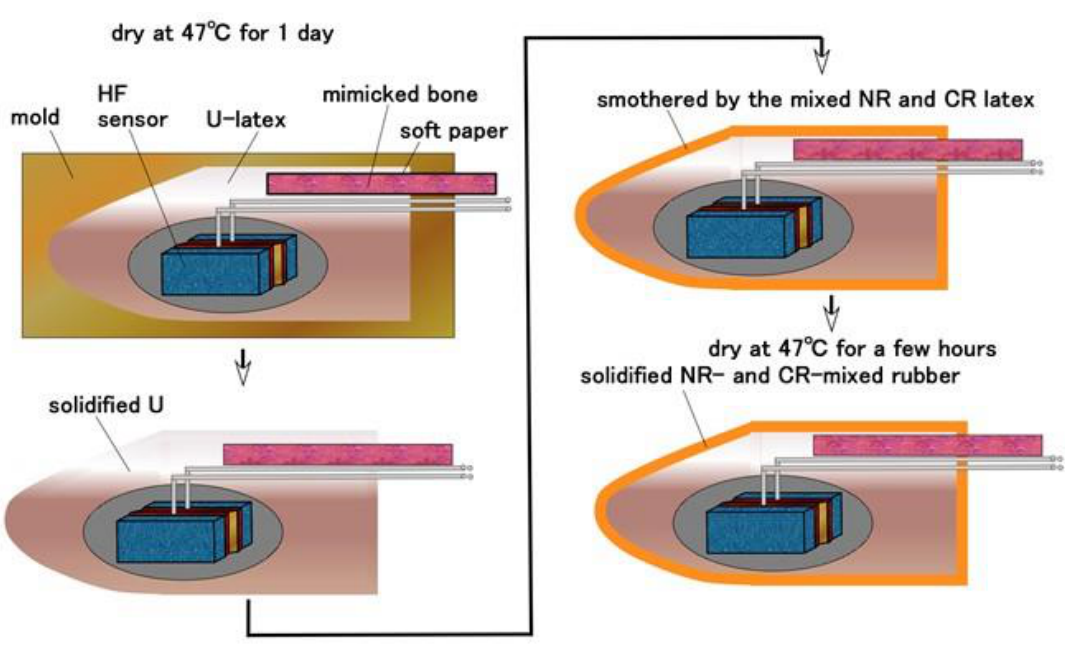
Figure 12. Fabrication of a finger with each of the cutaneous receptors embedded in U-rubber.